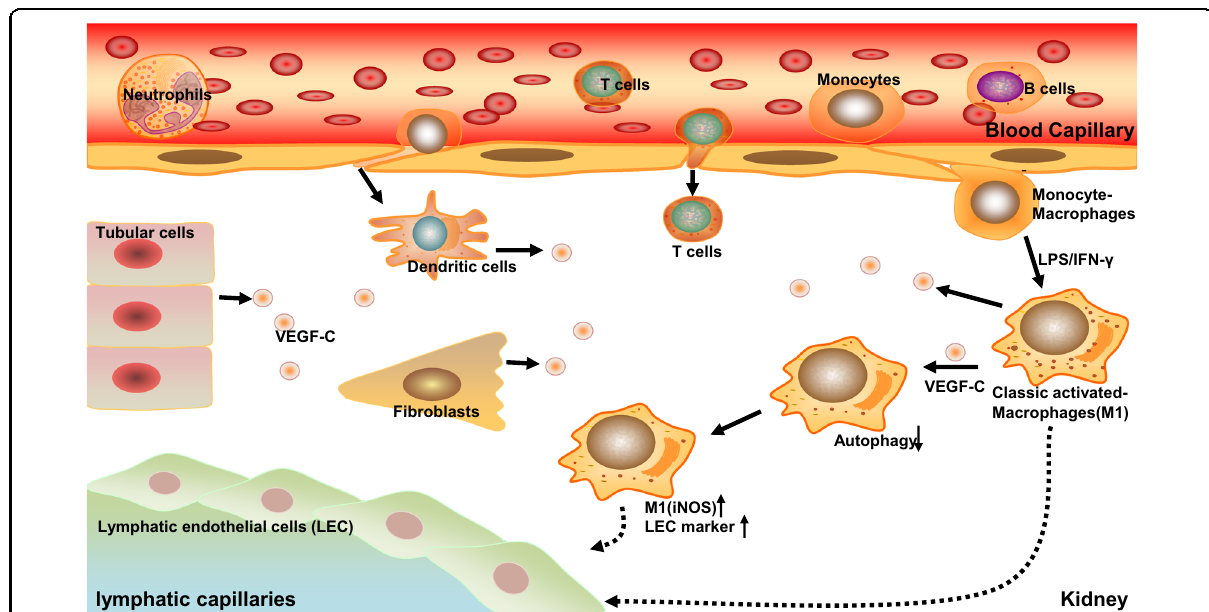
Fig. 9 Schematic diagram of how macrophages participate in lymphangiogenesis in renal fi brosis. When renal fi brosis is initiated, circulating in fl ammatory cells are chemically induced to home to the tissue, including macrophages, T cells, dendritic cells, and so on. Macrophages are polarized to M0, M1, and M2 phenotypes. Among them, M1 macrophages can preferentially transdifferentiate into LECs. During this process, the lymphatic growth factor VEGF-C, which is produced by in fi ltrated in fl ammatory cells, tubular cells, and other interstitial cells, suppresses M1 macrophage autophagy, thus upregulating M1 marker expression and polarization and ultimately promoting macrophage differentiation into